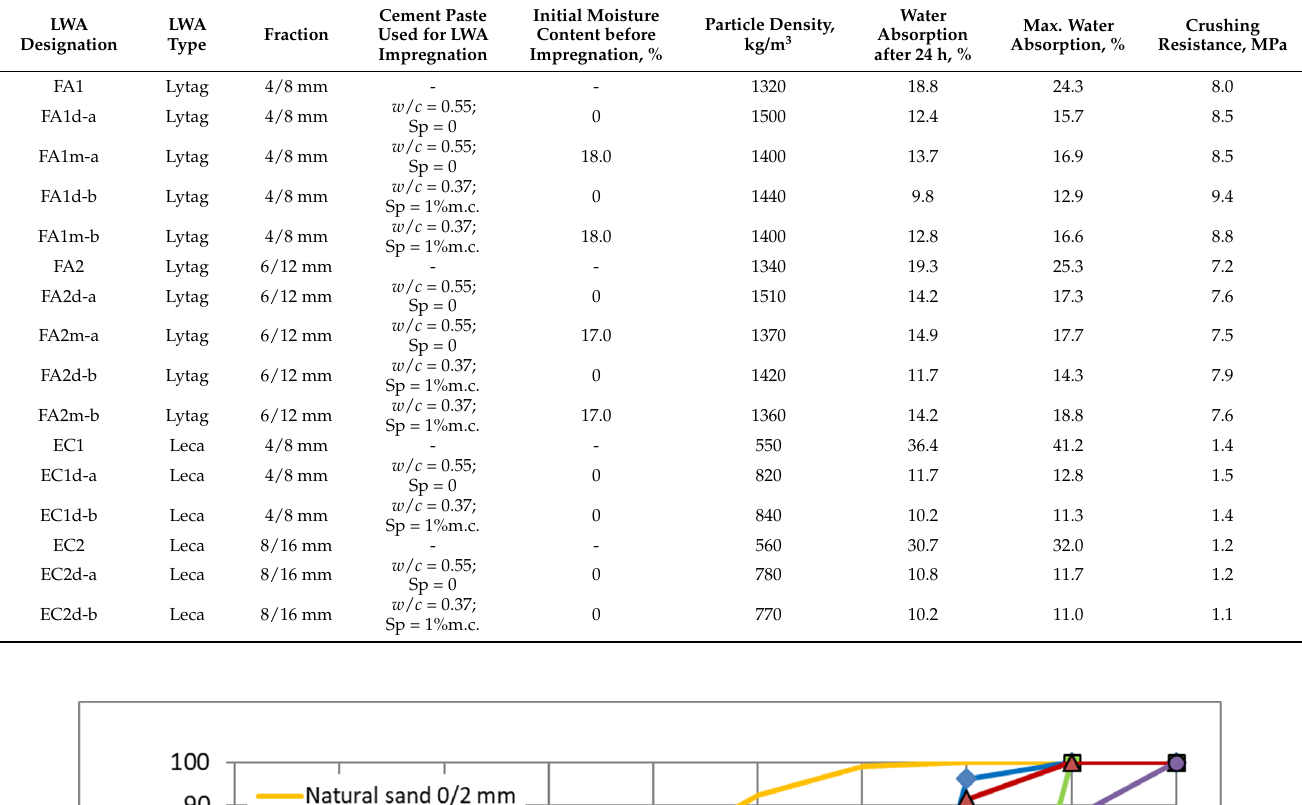
Table 1. Properties of plain and pre-coated lightweight aggregates used in the research.